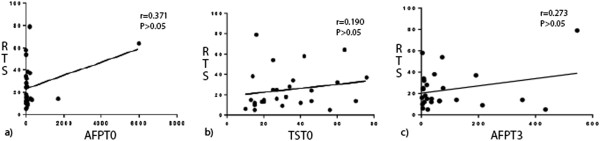
Correlations between studied variables and recurrent tumor size in patients who underwent TACE. (a) Pre-treatment serum AFP level (AFPT0) and recurrent tumor size (RTS) were not correlated (r = 0.371, P > 0.05). (b) Recurrent tumor size (TST0) and RTS were not correlated (r = 0.190, P > 0.05). (c) The 3-month post-treatment serum level (AFTT3) and RTS were not correlated (r = 0.273, P > 0.05).